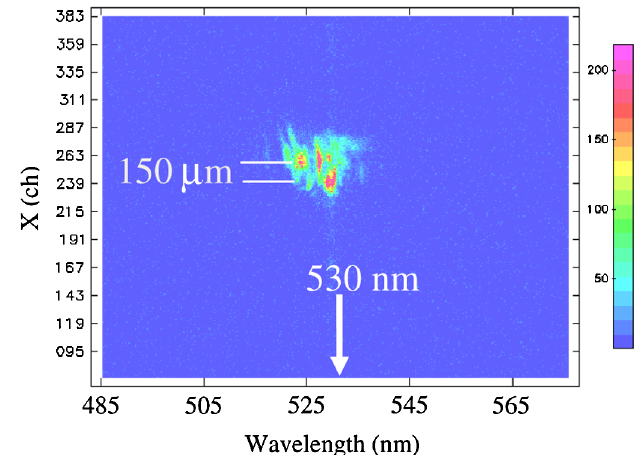
experiments.FIG. 13. (Color) The z -dependent gain curve for SASE at 530 nm taken by stepping through the nine VLD stations in decreasing order for data set 5 (diamonds) and for GENESIS simulations done for beam parameters for the 300-A case (squares) and the 260-A case (circles).